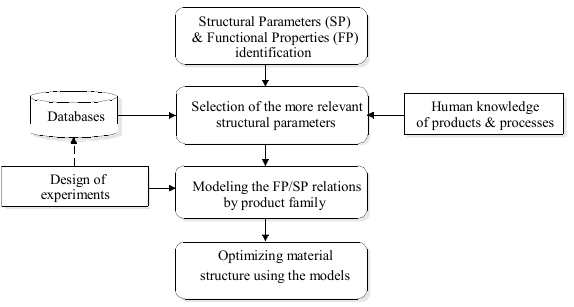
Fig. 2. Framework of the proposed design support